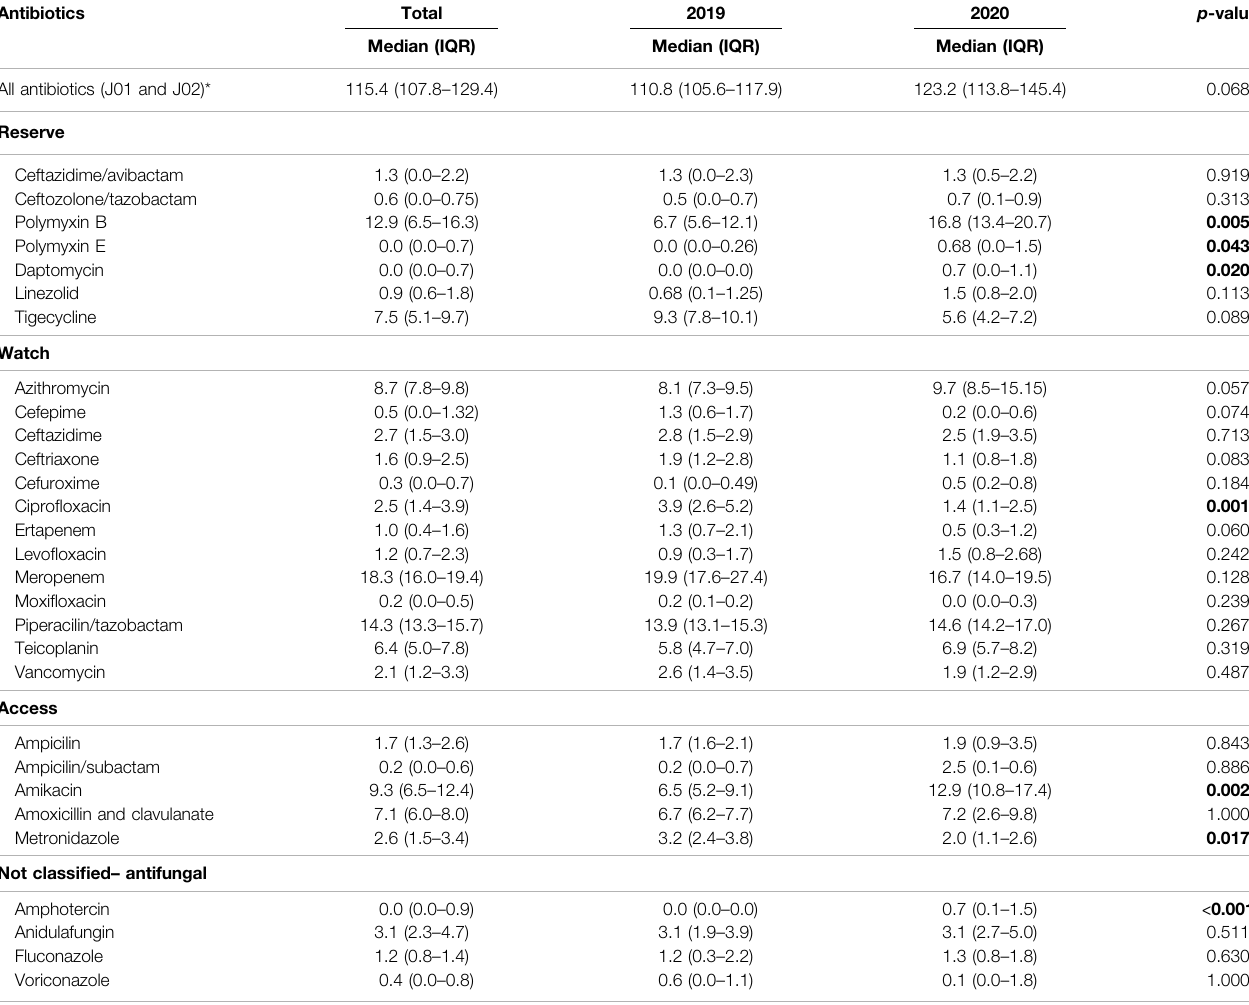
TABLE 2 | Median, interquartile range of antimicrobial consumption in DDD from January 2019 to December 2020 (Rio de Janeiro, Brazil). Antibiotics